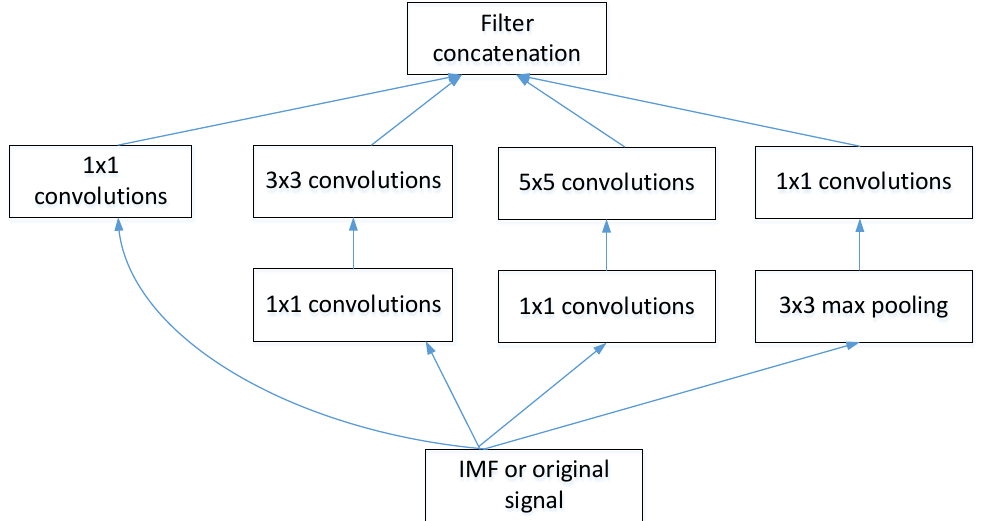
Figure 2. The structure of inception v1 module.